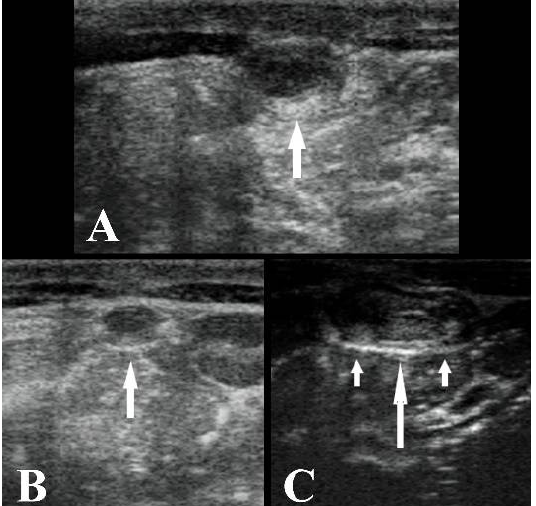
Figure 1. ( A ) Ultrasound image of the umbilical vein cranial to the umbilical stump at T0 (white arrow), transverse section. ( B ) Ultrasound image of the umbilical vein at the xiphoid cartilage at T0 (white arrow), transverse section. ( C ) Ultrasound image of the urachus (big white arrow) and left and right arteries (small white arrows) at T0, transverse section. The left side of the images is left, and the right side is right. B-mode, linear probe 7.5 MHz.